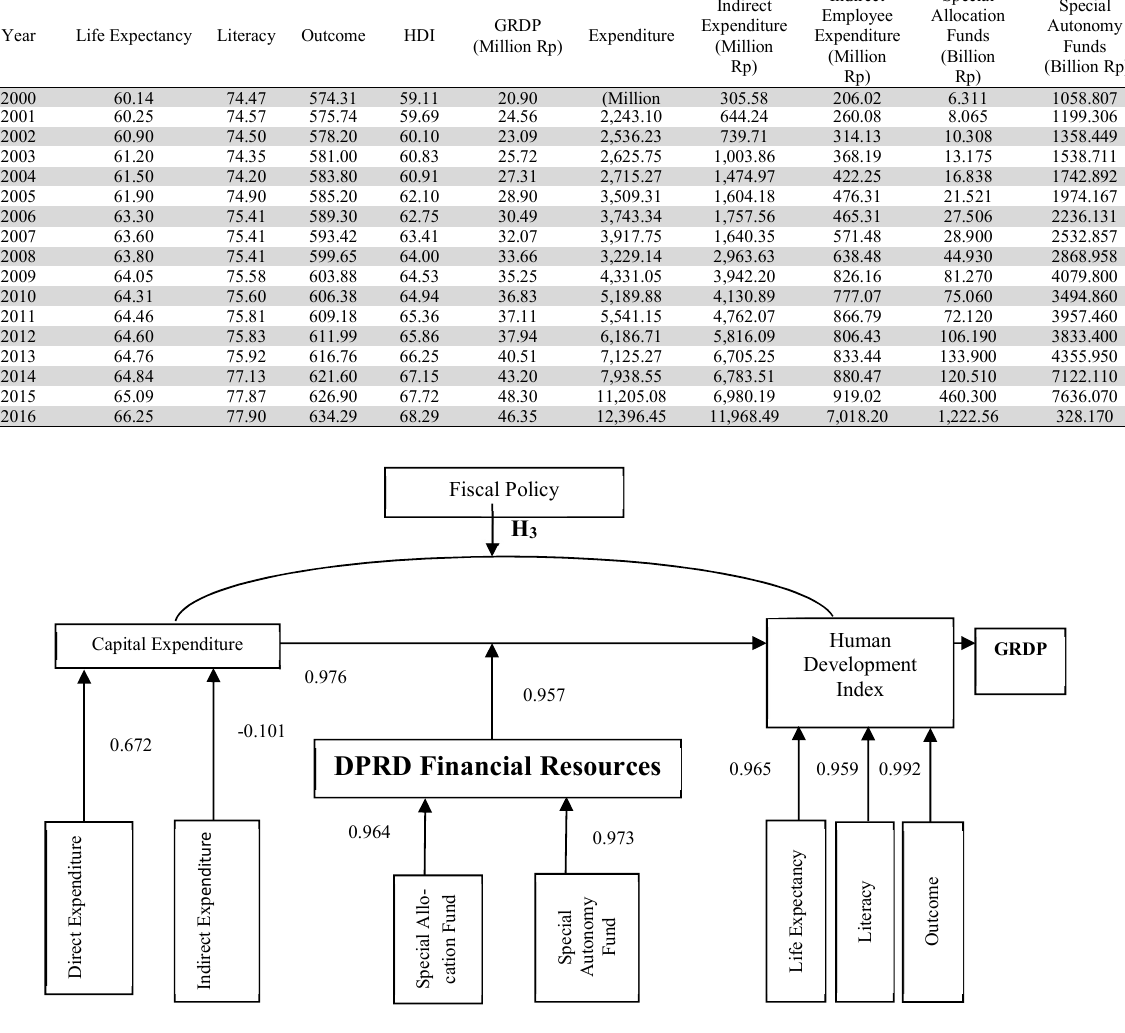
Fig. 2. The results of testing the